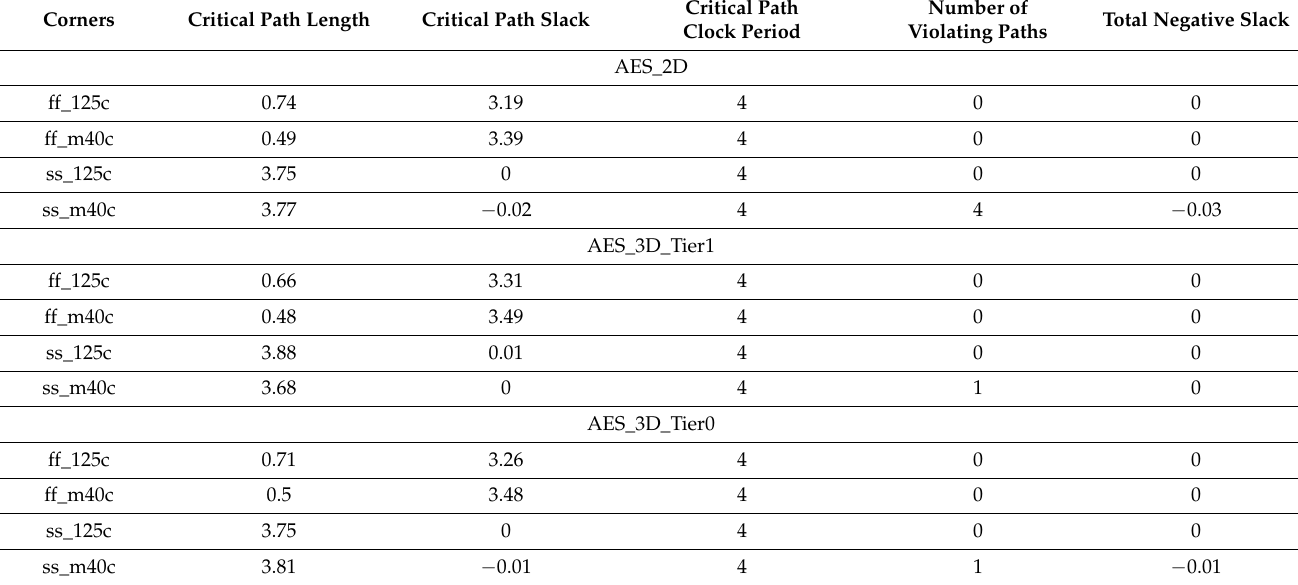
Figure 14. Cell density and wire utilization plots for two-tier AES 3D designs using the AQ partitioner. Table 3. Timing analysis results for 2D and two-tier 3D AES benchmark circuit.